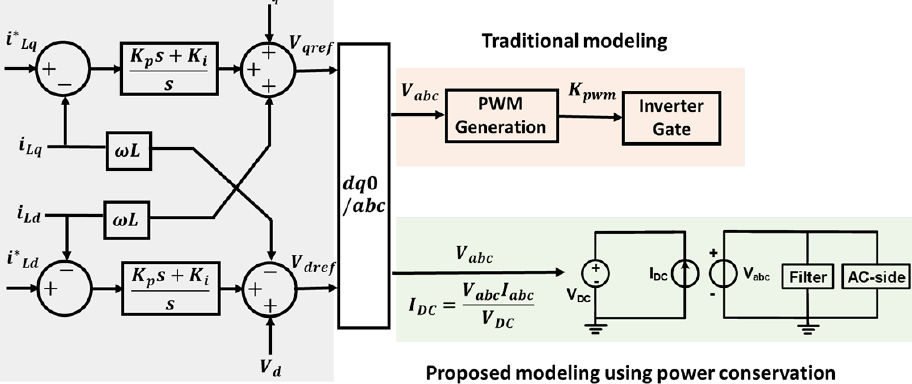
Figure 8. Control diagram of grid-following inverter controller.